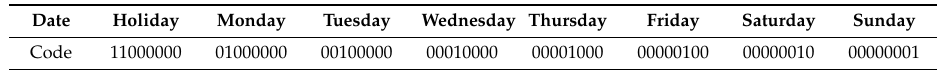
Table 5. The encryption of days.